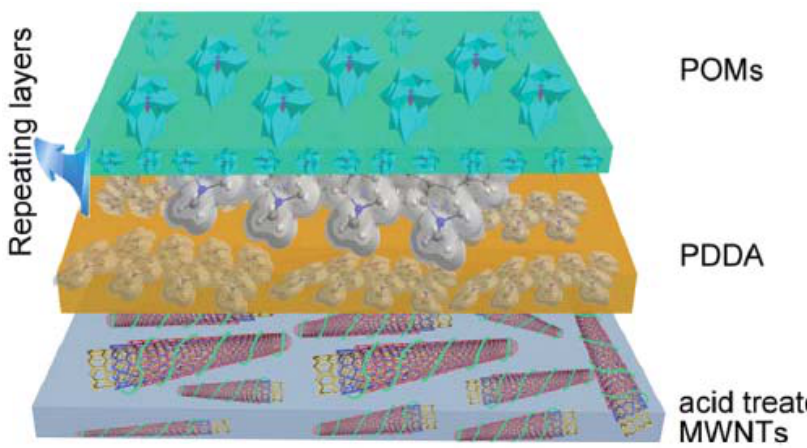
Fig. 10. TEM image of the POM/SWNT hybrid material. Adapted from Ref [61].